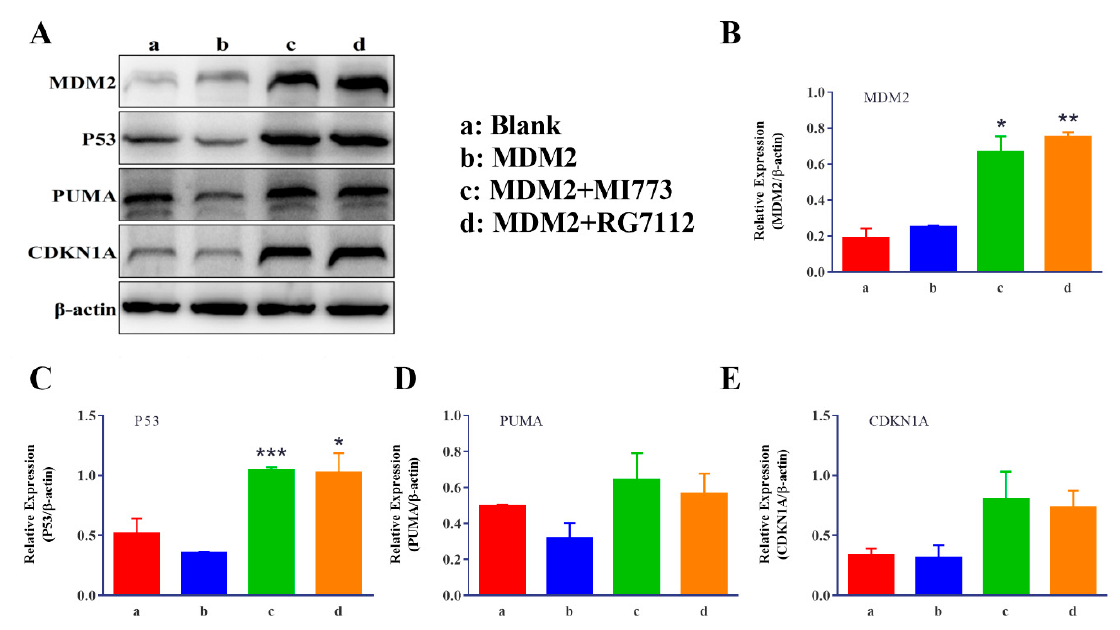
Figure 7. ( A ) Band diagrams of proteins associated with P53 signal pathways with the experimental condition of 1 μ M MI773 or 5 μ M RG7112 determined by Western blot analysis, the a − d lanes were blank, MDM2 plasmid, MDM2 plasmid and 1 μ M MI773, MDM2 plasmid and 5 μ M RG7112, sepa ‐ rately. ( B ) The expression of MDM2 with the experimental condition of 1 μ M MI773 or 5 μ M RG7112 was determined by Western blot analysis. ( C ) The expression of P53 with the experimental condition of 1 μ M MI773 or 5 μ M RG7112 was determined by Western blot analysis. ( D ) The expression of PUMA with the experimental condition of 1 μ M MI773 or 5 μ M RG7112 was determined by Western blot analysis. ( E ) The expression of CDKN1A with the experimental condition of 1 μ M MI773 or 5 μ M RG7112 was determined by Western blot analysis ( n = 3). Compared to the MDM2 group, * p < 0.05, ** p < 0.01, *** p < 0.001, and **** p < 0.0001.